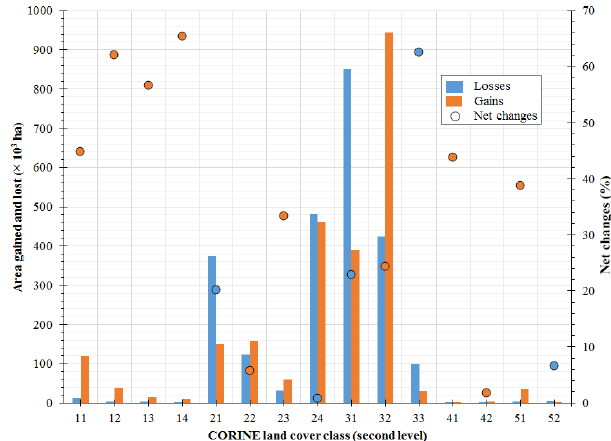
Figure 5. Area lost and gained from 1990 to 2012 for each CORINE land cover class, considering the second-level hierarchy. Net per- centage changes were computed relative to the total area of each class in the later land cover.